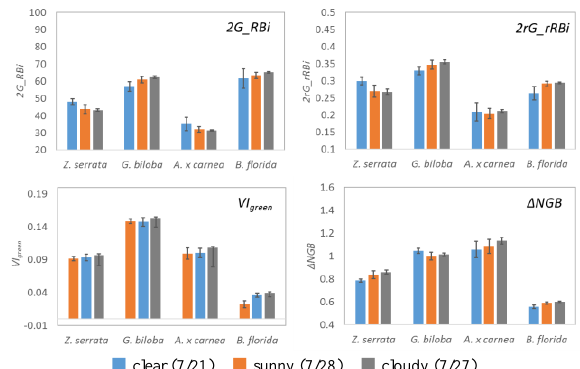
Figure 4. The average with standard deviation of image indices under clear, partly cloudy, and cloudy